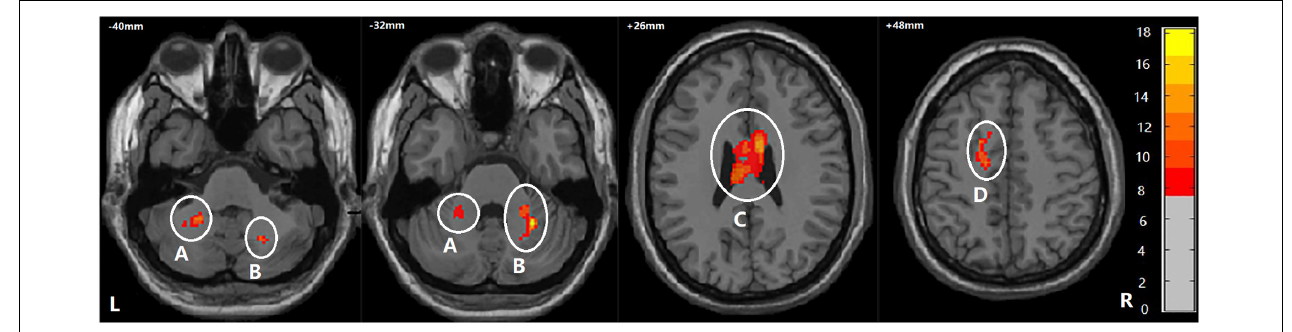
FIGURE 2 | Regions showing WM differences among the BD + S, BD-S, and HC groups. A, the left middle cerebellar peduncle; B, the right middle cerebellar peduncle; C, the bilateral body and genu of corpus callosum; D, the left superior corona radiate. The number is z-coordinate; The color bar is the range of F -values; L, left; R,